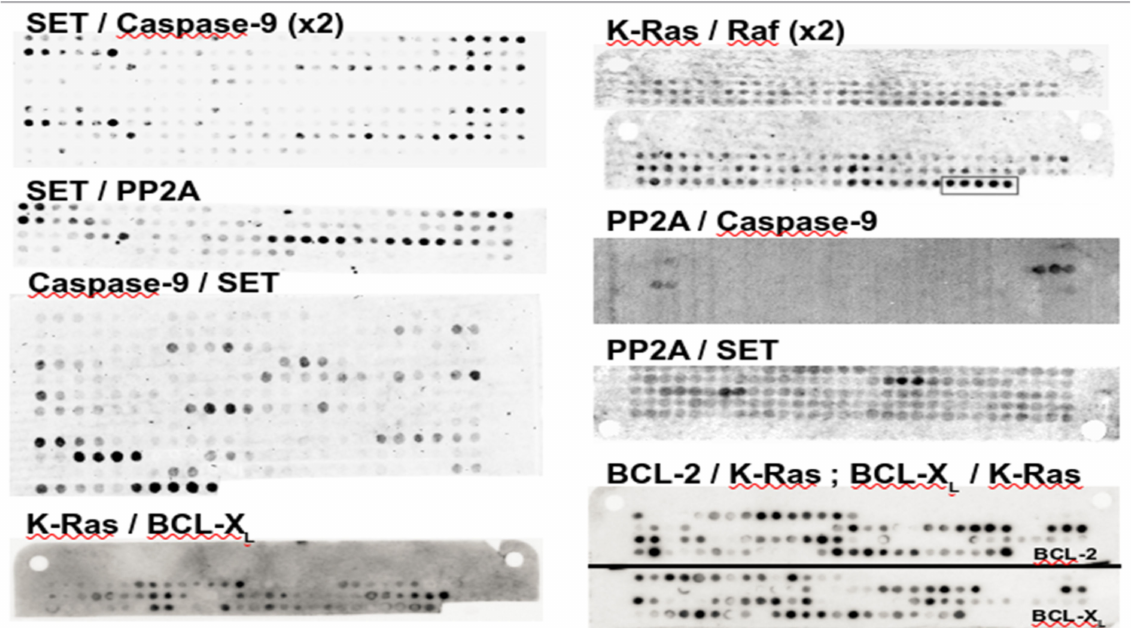
Figure 1. PEPscan membranes. For several cases, the images show the membranes resulting from the PEPscan experiment. Each spot in a raw image corresponds to a peptide of 12 amino acids, and consecutive spots share 10 amino acids in common. Black spots correspond to positive reacting spots. P1/P2 (e.g., SET/PP2A) indicates that P1 (resp. SET) is on the membrane that is hybridized using P2 (resp.